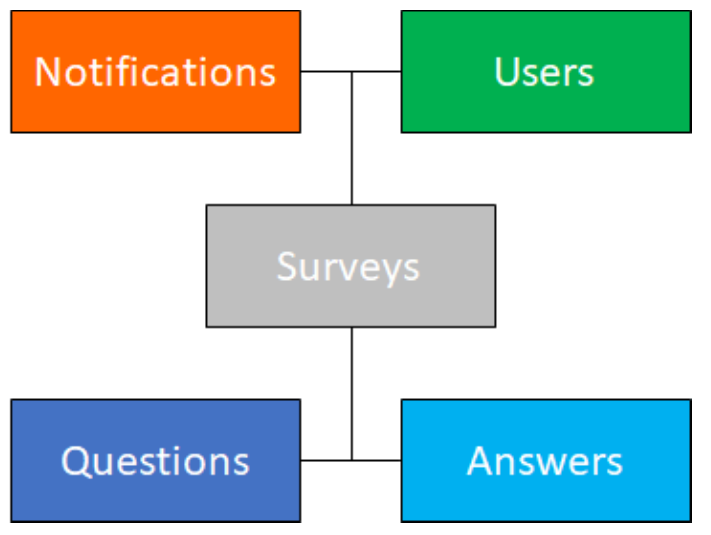
Figure 2. Generic scheme of the database structure